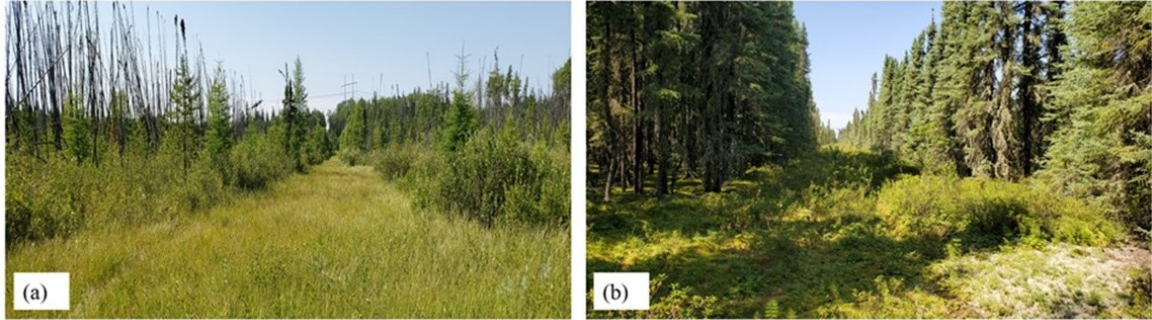
Figure 2. Examples of seismic line transects for shrub and tree height validation through ( a ) burned peatland and ( b ) forest looking into an unburned treed